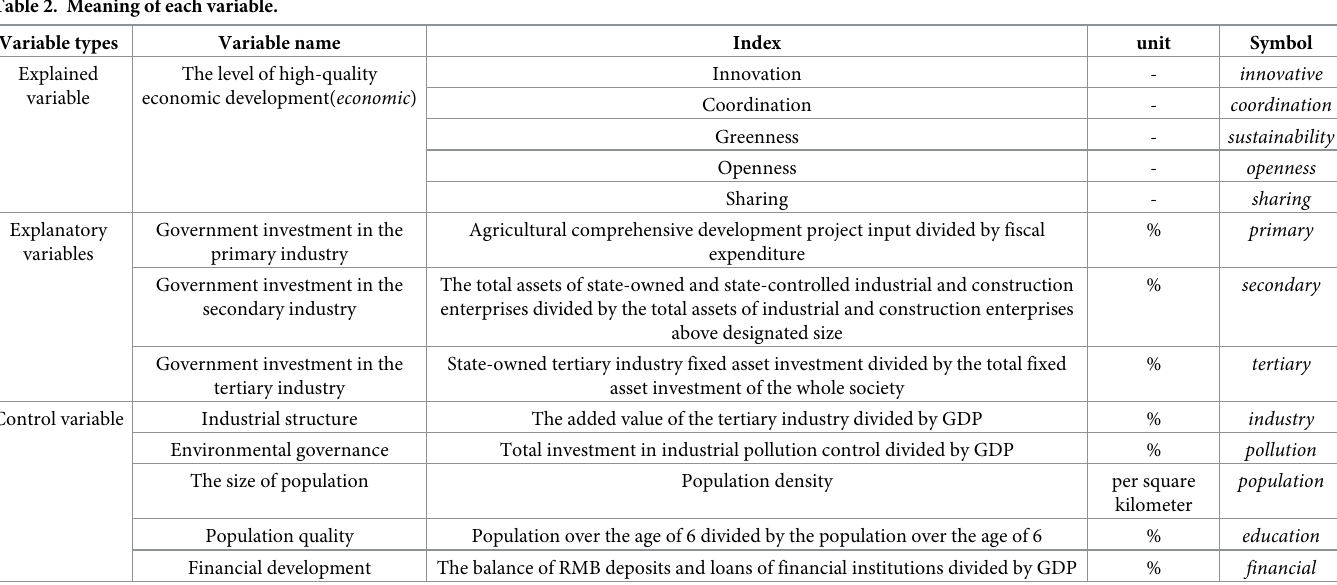
Table 2. Meaning of each